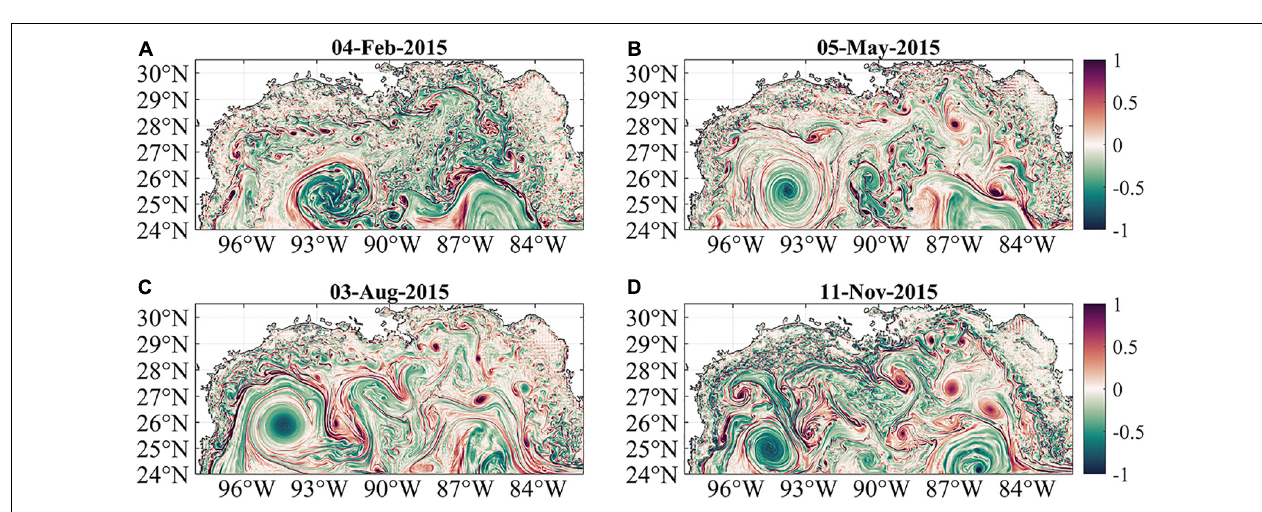
FIGURE 4 | Relative vorticity fields normalized by the Coriolis frequency ζ /f in February (A) , May (B) , August (C) , and November (D) , 2015 in the SP simulation.